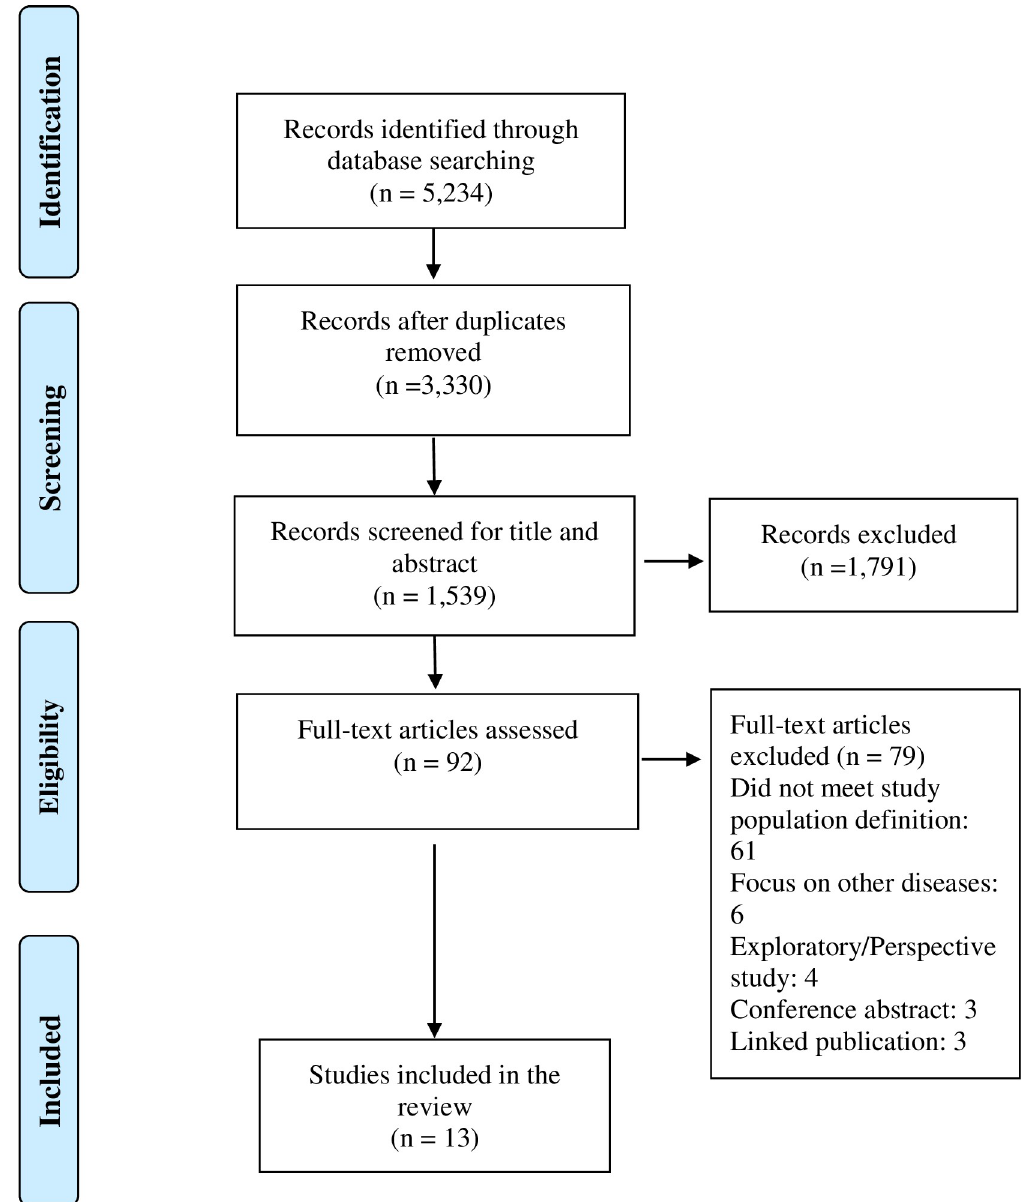
Fig 1. PRISMA-ScR flow diagram of study selection and inclusion